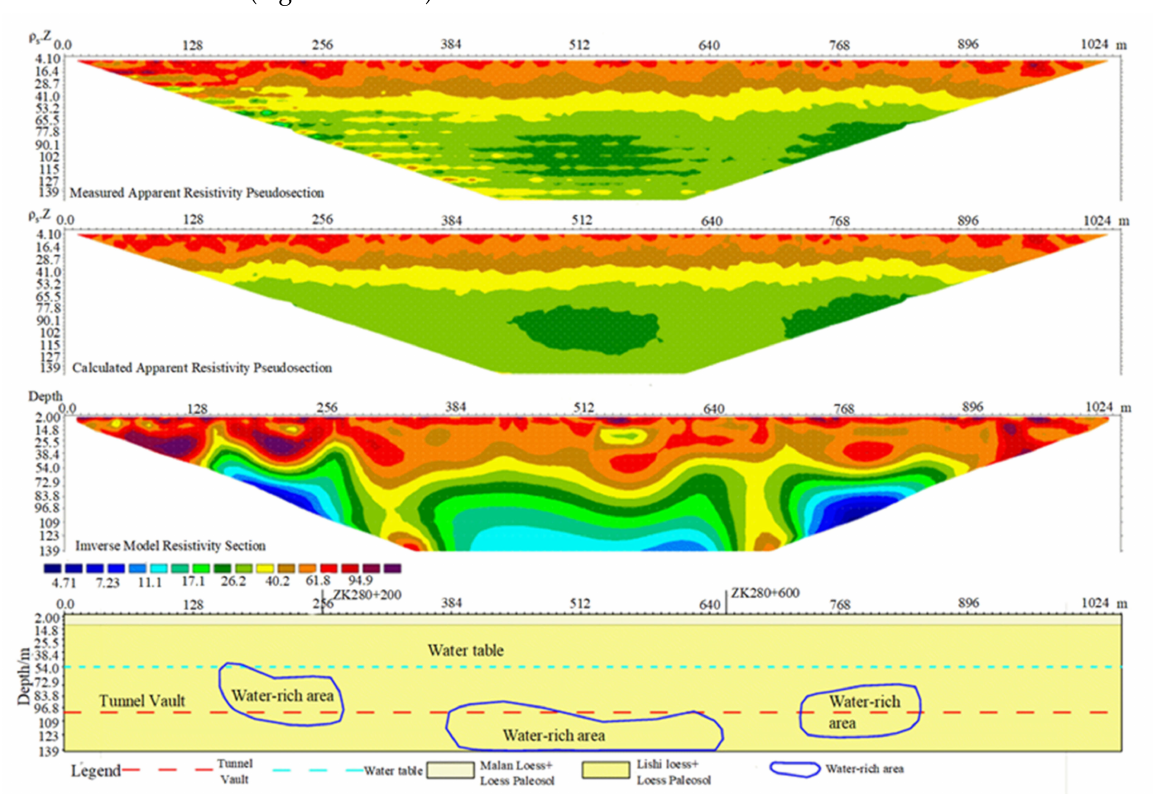
Figure 2. Groundwater distribution area in longitudinal section of tunnel.